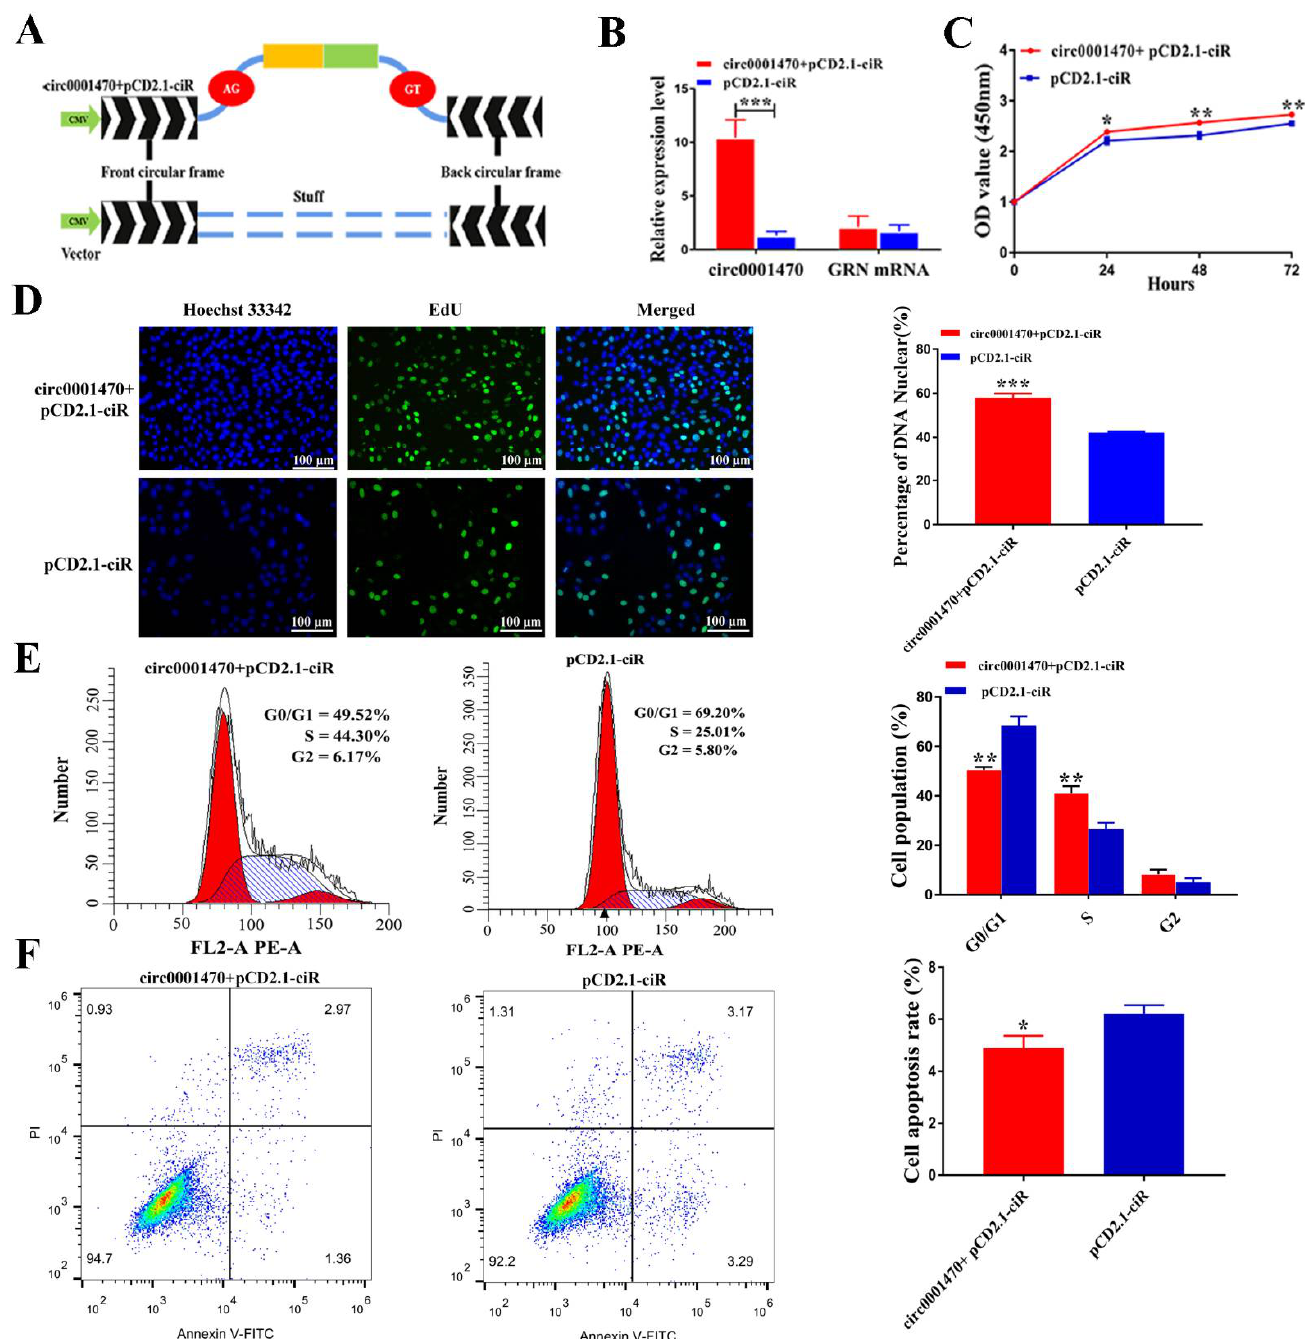
Figure 3. Circ0001470 promotes EECs proliferation, and cycle transition and suppresses apoptosis. ( A ) Schematic illustration of circ0001470 expression vector. ( B ) qRT-PCR analysis of circ0001470 and GRN mRNA in EECs after overexpression circ0001470. ( C ) CCK-8 demonstrated the proliferation ability of EECs transfected with circ0001470 or the vector. ( D ) The proliferation of EECs transfected with circ00001470 overexpression plasmids or vector treatment was detected by EdU assays. Scale bars, 100 μm. ( E ) Cell cycle distribution was measured in EECs transfected with circ0001470 or vector. ( F ) FCM analysis shows the ratios of apoptotic EECs with the treatment of circ0001470 or vector. Data are shown as mean ± SD; All data are representatives of three independent experiments. * p < 0.05, ** p < 0.01, *** p <